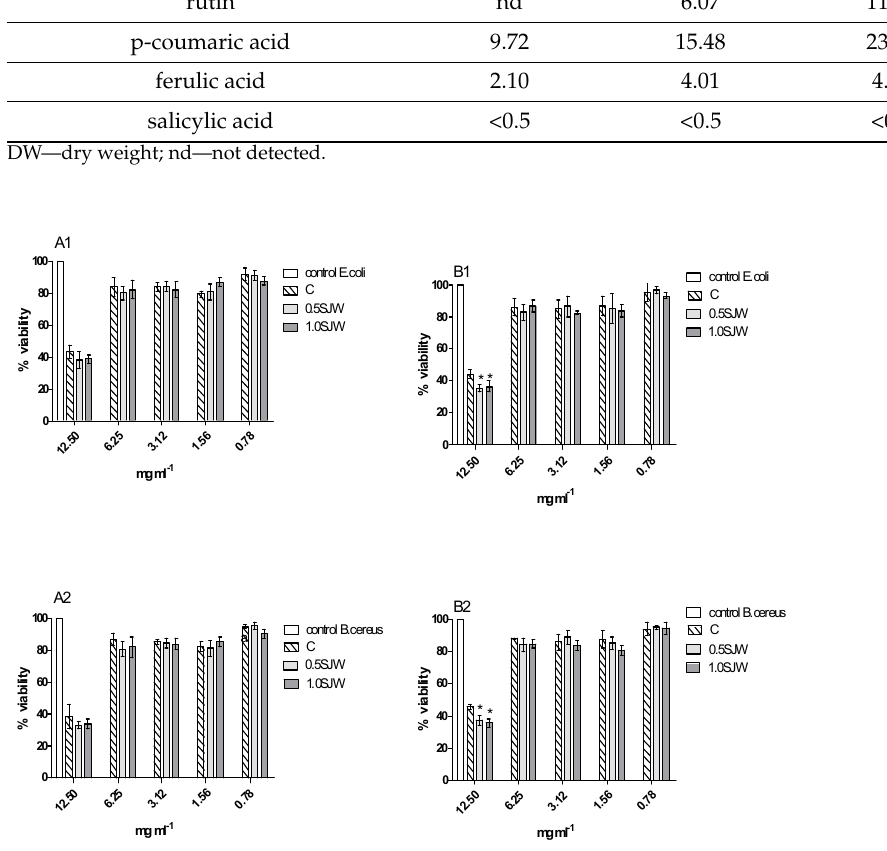
Figure 2. Viability (in %) of E. coli ATCC 25922 and B. cereus ATCC 14579 against hydrolyzates ( A1 , A2 ) and fractions ( B1 , B2 ) of samples: 0.5 SJW, 1.0 SJW, and control (cookies without St. John’s wort).